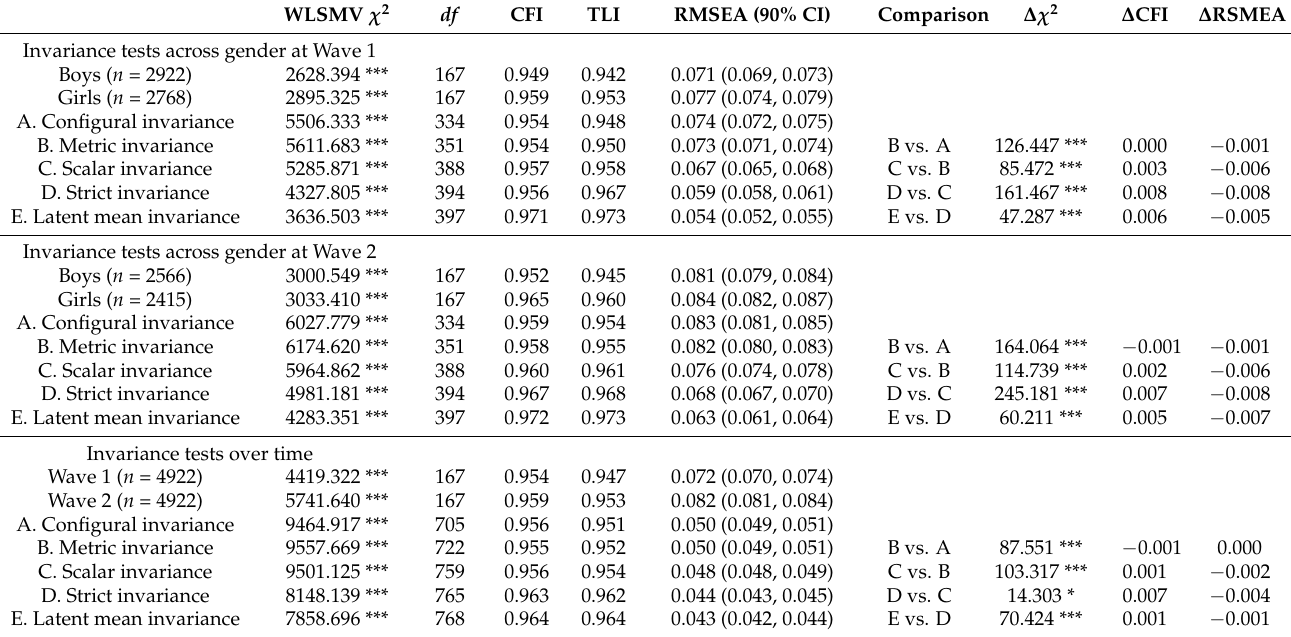
Table 4. Measurement invariance tests across gender based on the full samples at Wave 1 and Wave 2 and over time based on the matched sample.